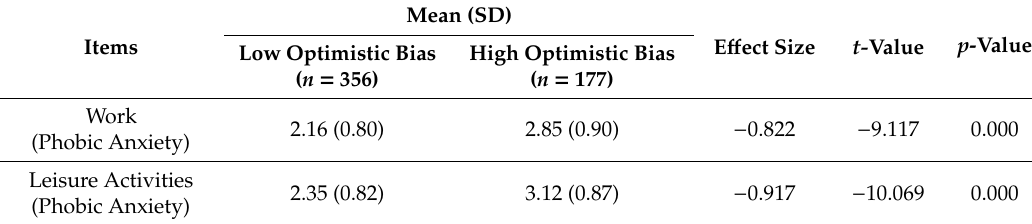
Table 3. Analysis of di ff erences according to optimistic bias ( n =